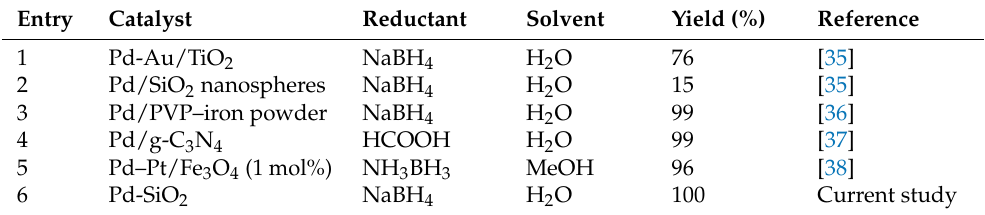
Table 1. Comparison of catalytic performance for the reduction with Pd and other catalysts.